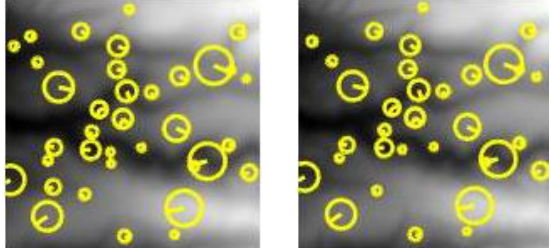
Figure 5. SIFT point extraction results: SoI (left) and SRTM (right) for area #1.